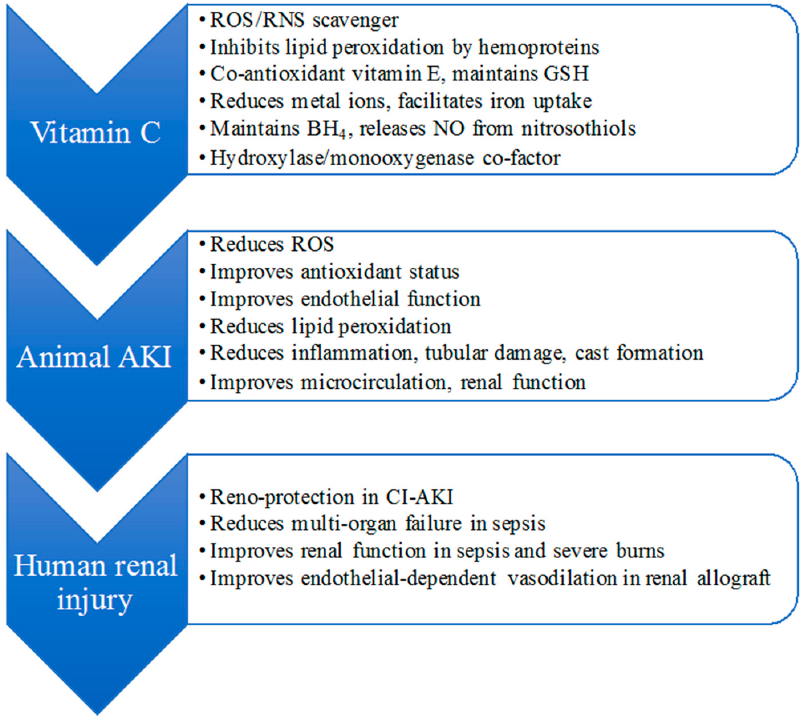
Figure 2. Key activities of vitamin C and proposed benefit mechanisms in acute renal injury. BH4 = tetrahydrobiopterin; RNS = reactive nitrogen species; CI-AKI = chemical induced acute kidney injury